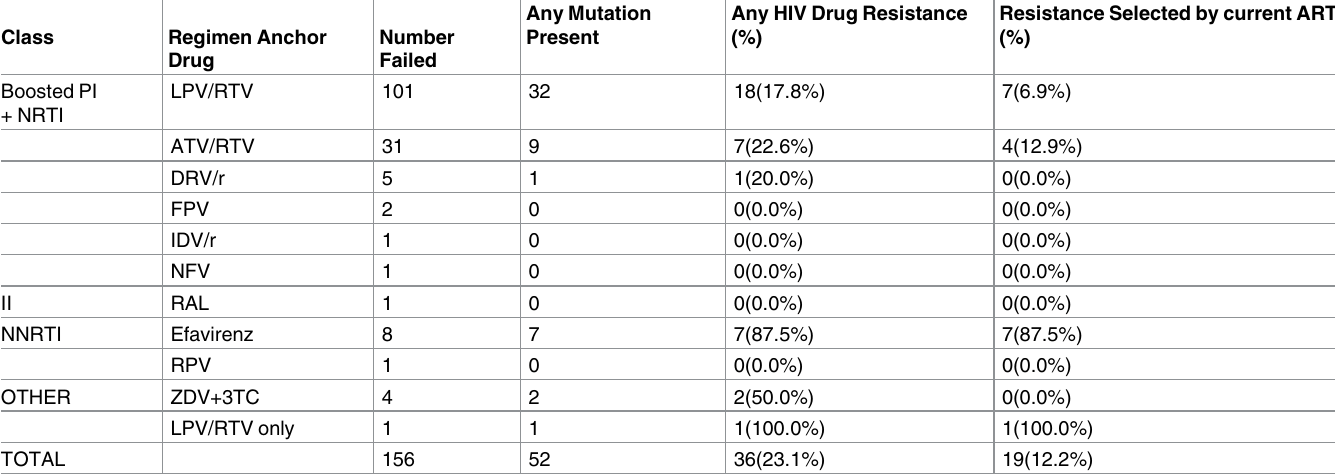
Table 5. Resistance mutations and ART